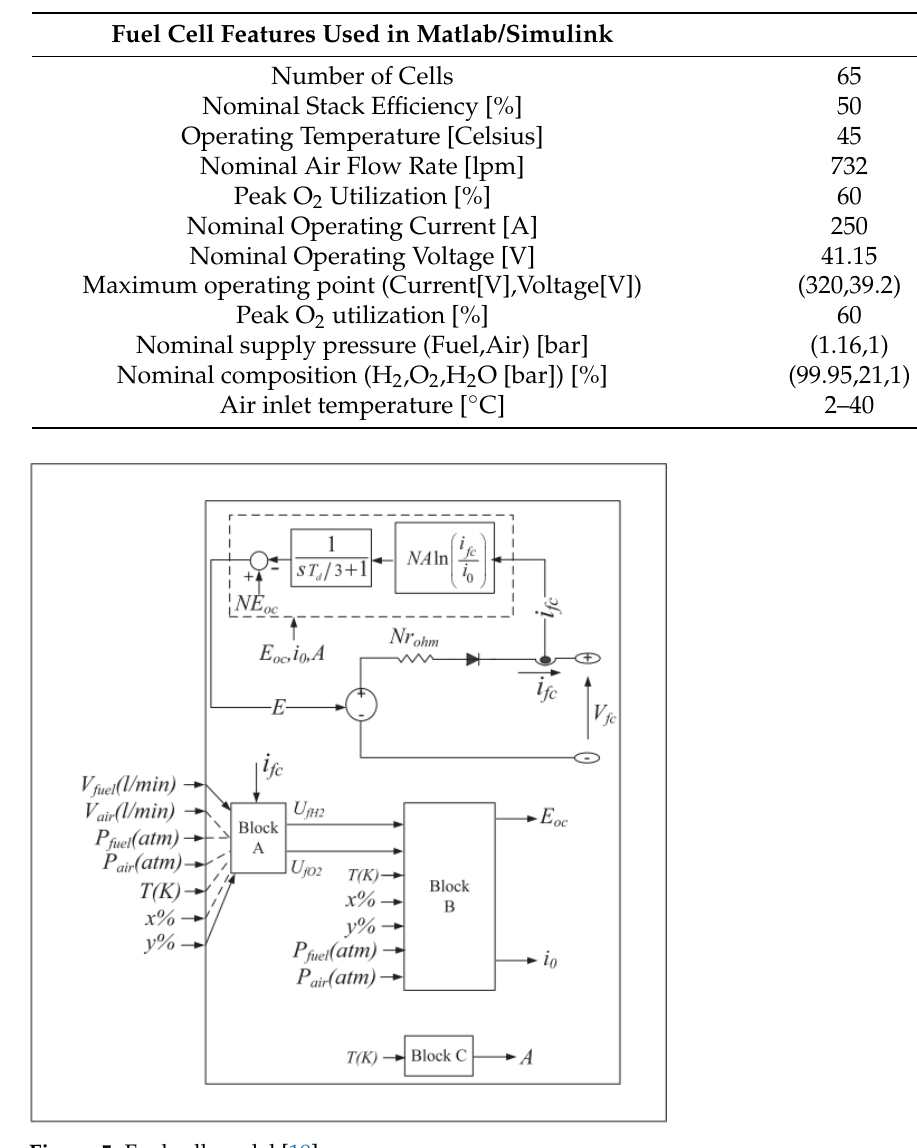
Table 5. Specifications of the fuel cell used in the system.